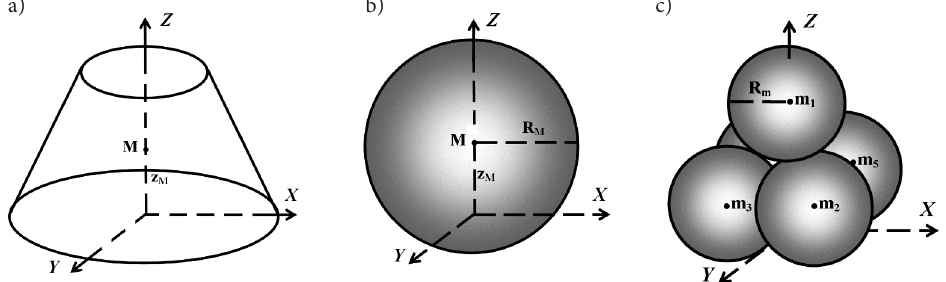
Figure 1. Truncated cone and the approximation model of its gravitational